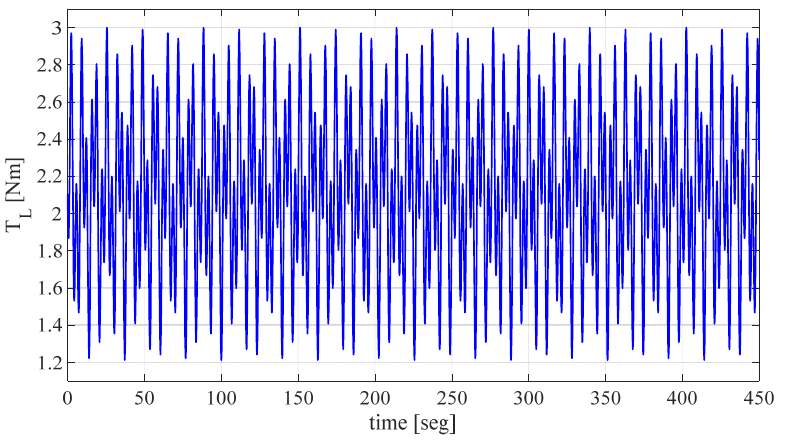
Figure 10. Variable load torque applied to the PMSM.